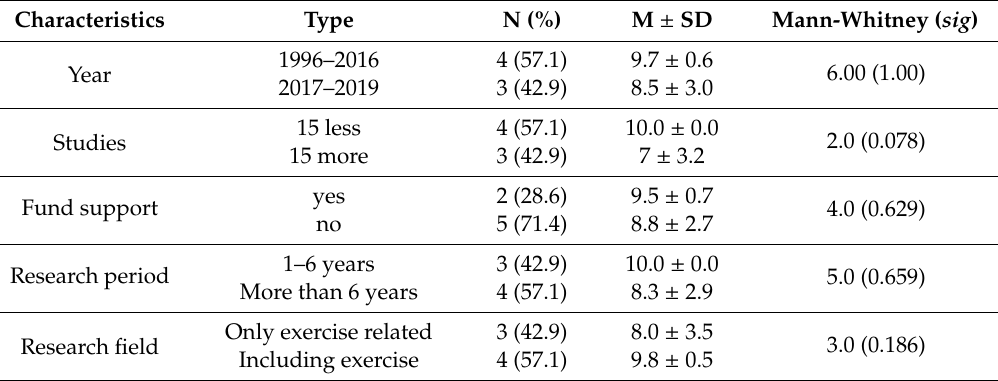
Table 7. Di ff erences in the AMSTAR quality score according to research characteristics.